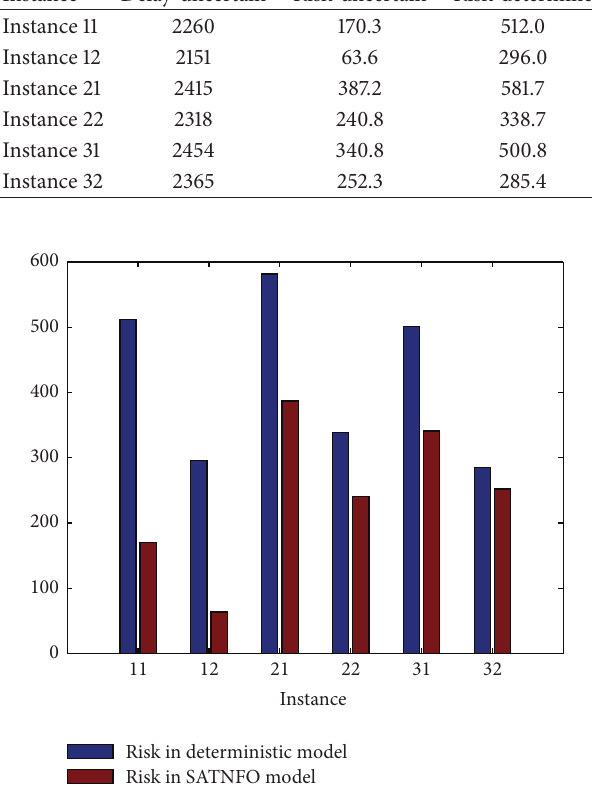
Figure 4: Demonstration of risk in deterministic model and our SATNFO model.